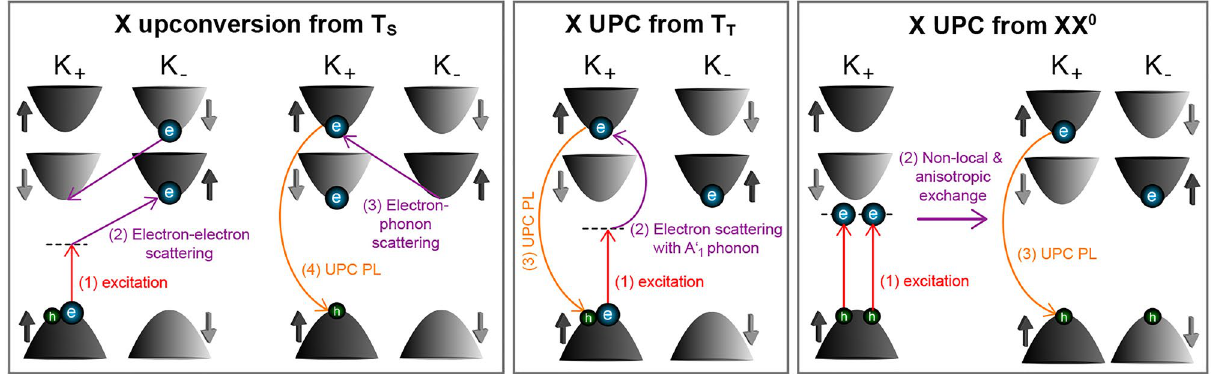
Figure 3. Schematic presentation of the mechanisms of the exciton upconversion involving the spin-singlet and spin-triplet trions as well as the neutral biexciton. The single-particle picture is chosen, where an electron (a hole) is sketched by a blue (green)